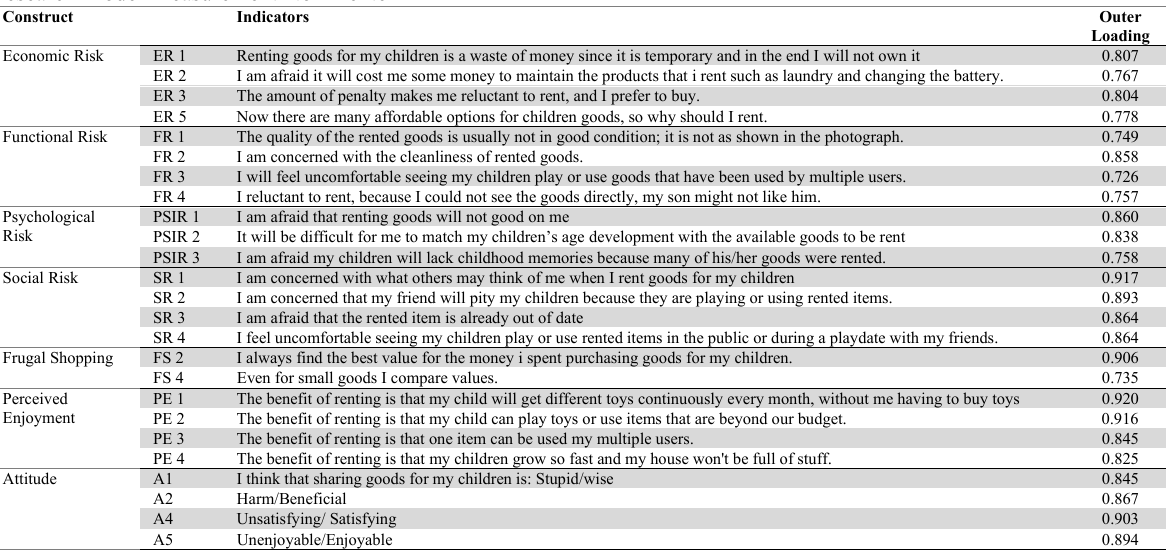
Research Model Measurement Non-Renter Construct Indicators Outer Economic